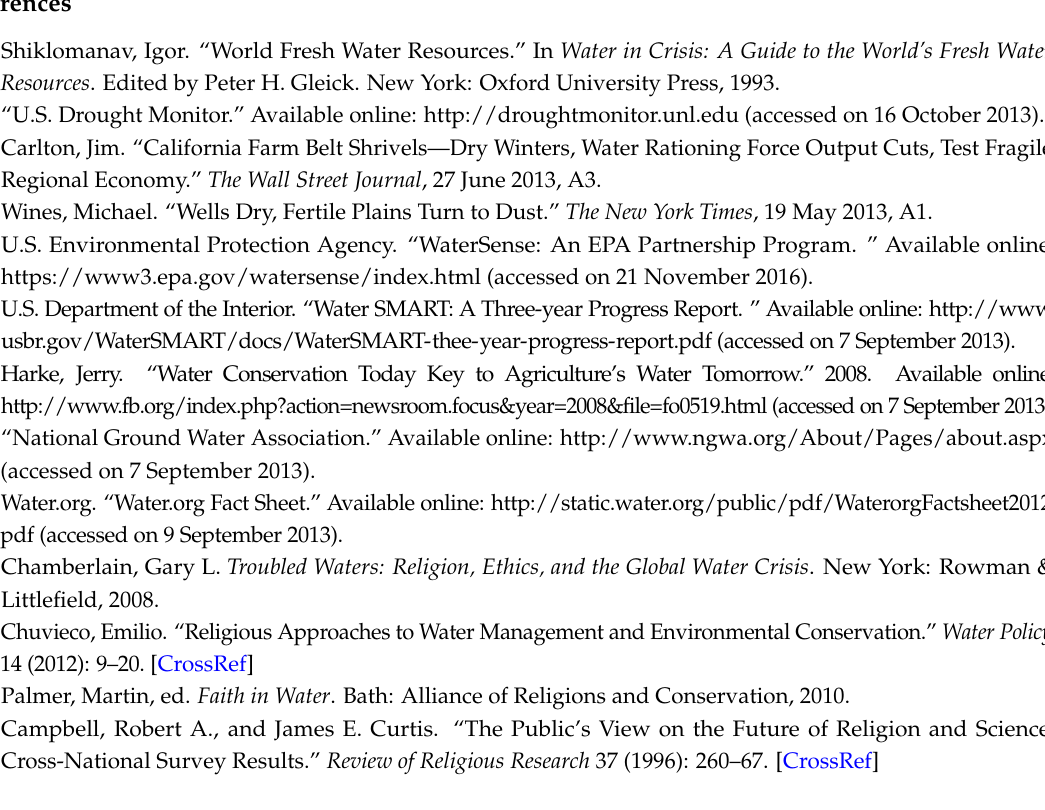
4/76/S1, Figure S1: Confirmatory factor analysis model, Table S1: Descriptive statistics for CFA model latent variables and